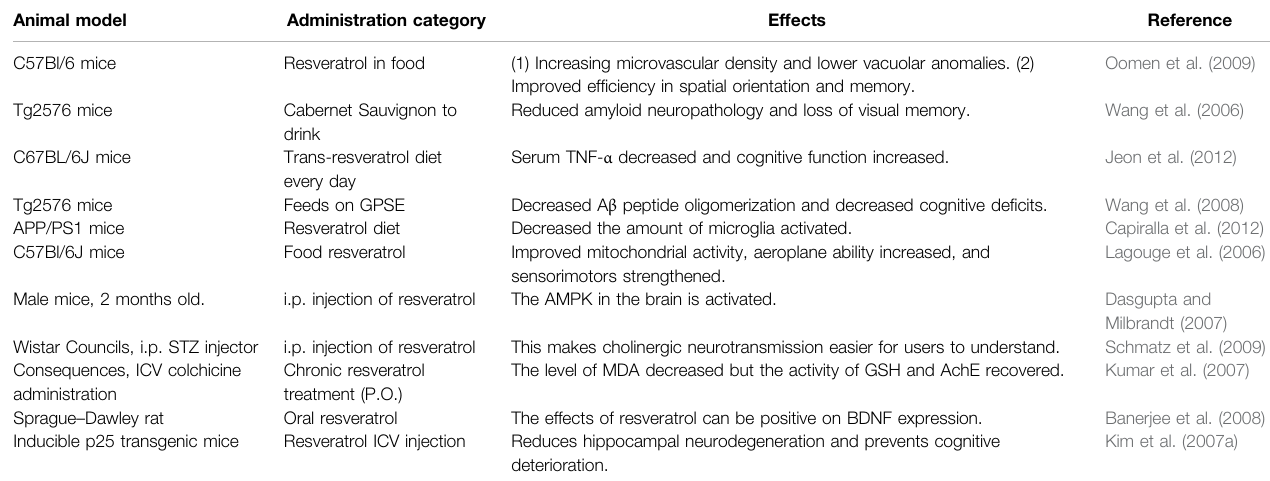
TABLE 1 | Neuroprotective effects of resveratrol in vivo